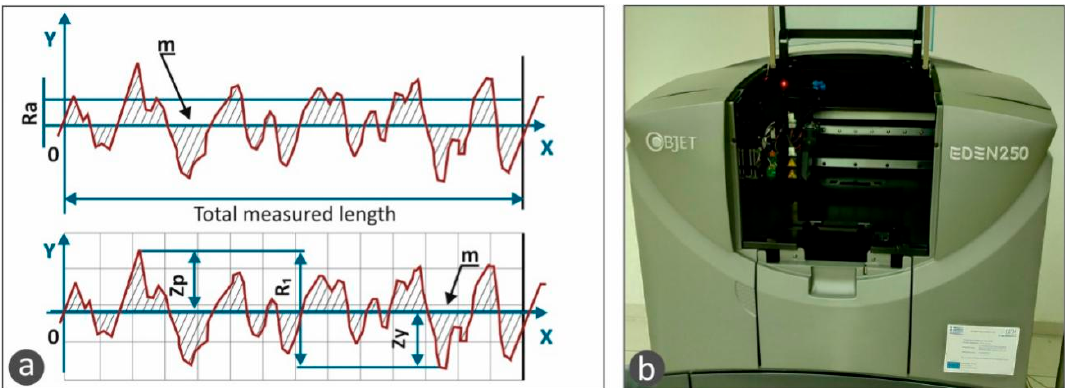
Figure 5. ( a ) Surface texture parameters; ( b ) Eden250™ 3D Printing System.